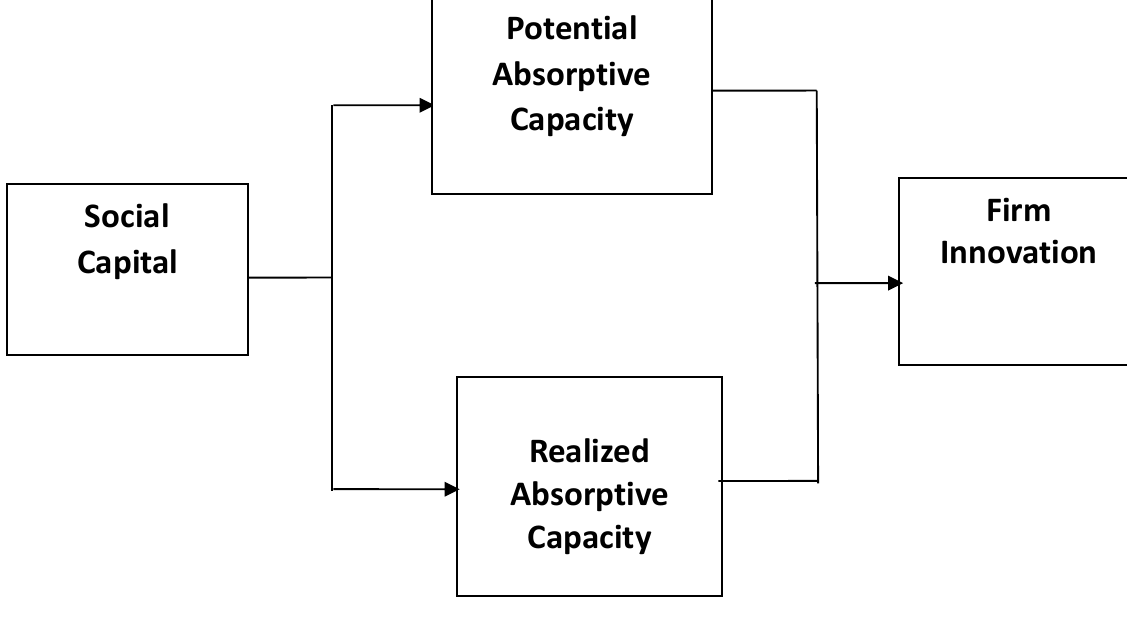
Figure 1: Research